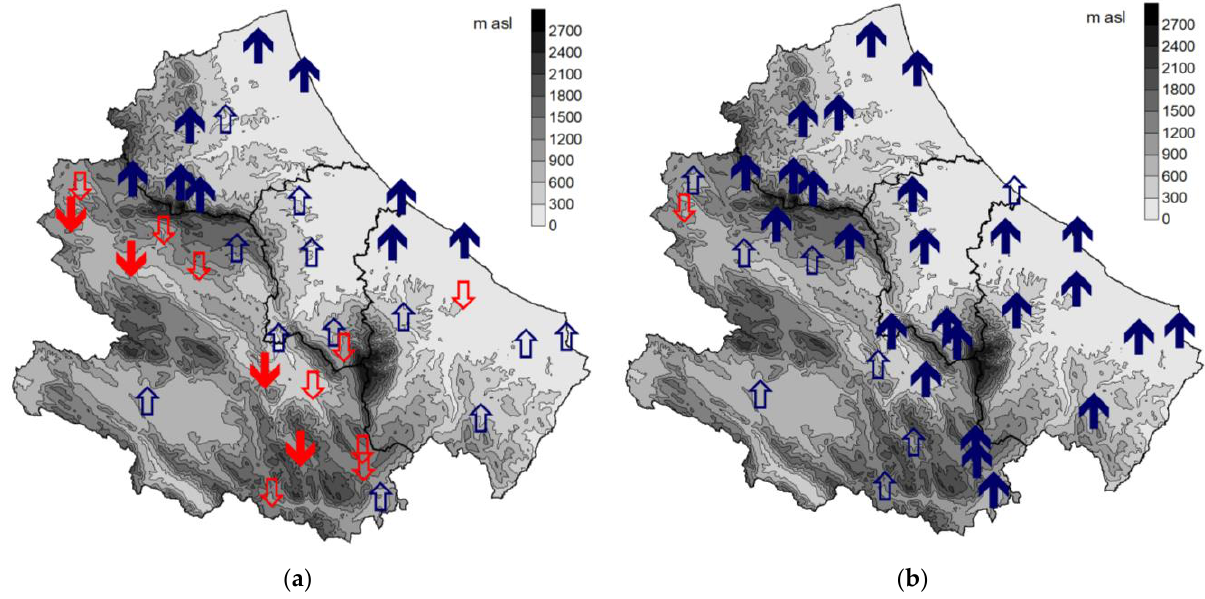
Figure 7. Spatial distribution of trend in MFI series (1980–2018): ( a ) point data; ( b ) grid E-OBS data. The down arrows indicate decreasing trends, while upper arrows denote increasing trends. Solid arrows indicate significant trends ( p -Value < 0.10) according to Mann–Kendall test.